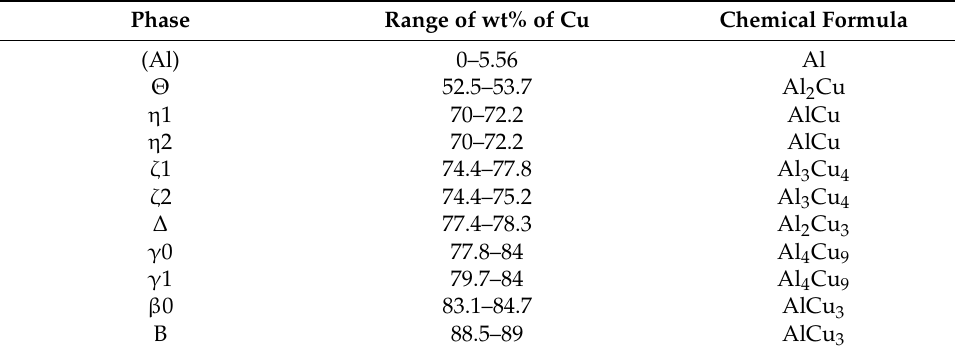
Table 3. wt% Cu in intermetallic compounds (IMCs) according to Al-Cu phase diagram [36]. Phase Range of wt% of